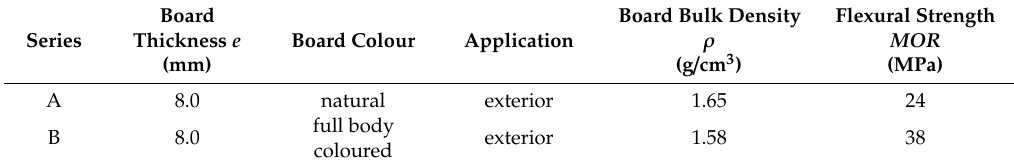
Table 1. Basic specifications of the tested fibre-cement boards of series A and B.